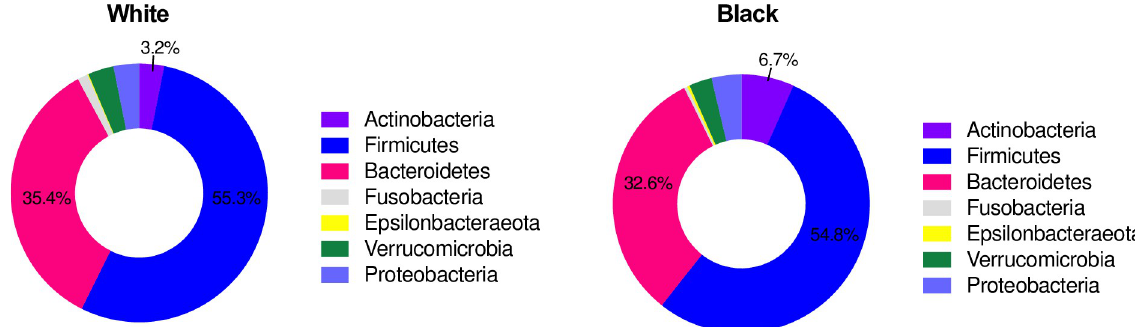
Fig 1. Comparison of relative abundance of bacteria in fecal samples by phylum in White and Black women. Relative abundance was measured by 16S rRNA gene PCR and sequencing.